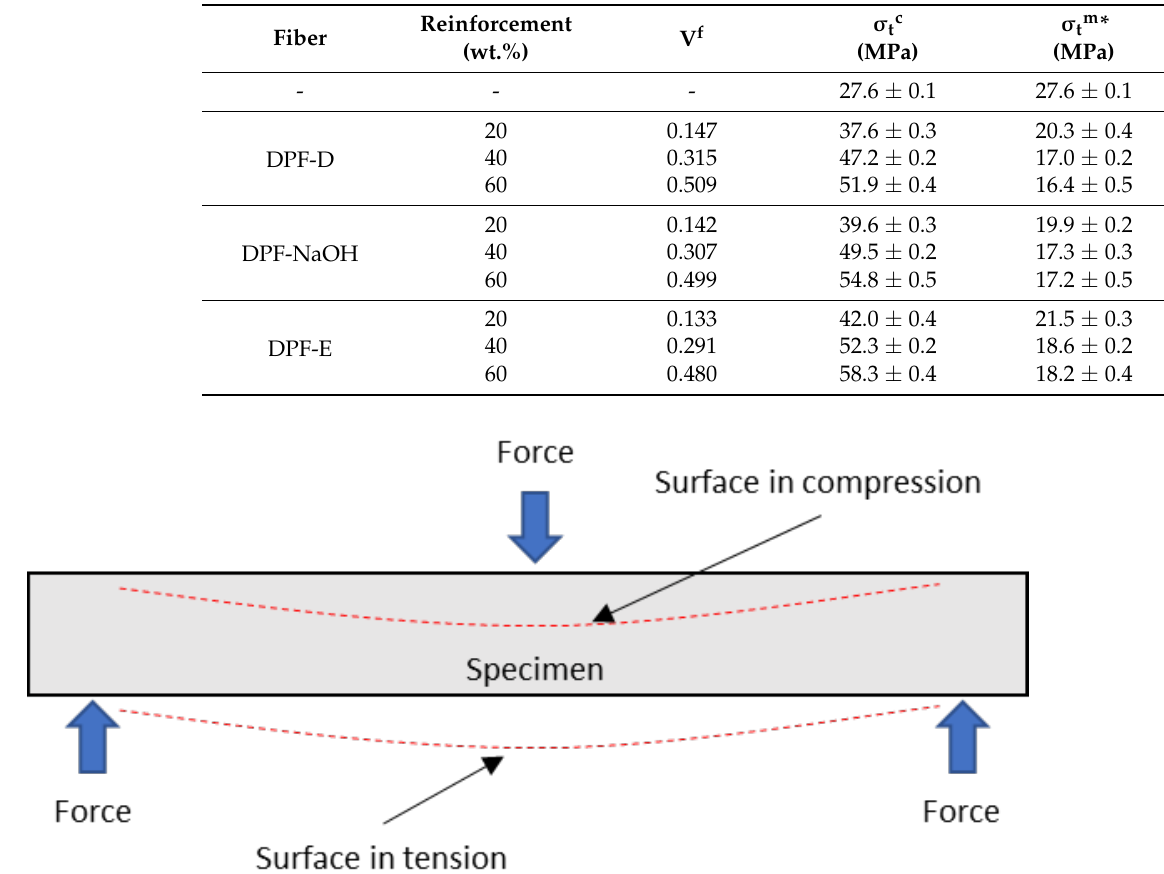
Table 4. Tensile strength of composite and matrix contribution to the tensile strength of date palm fiber composites.